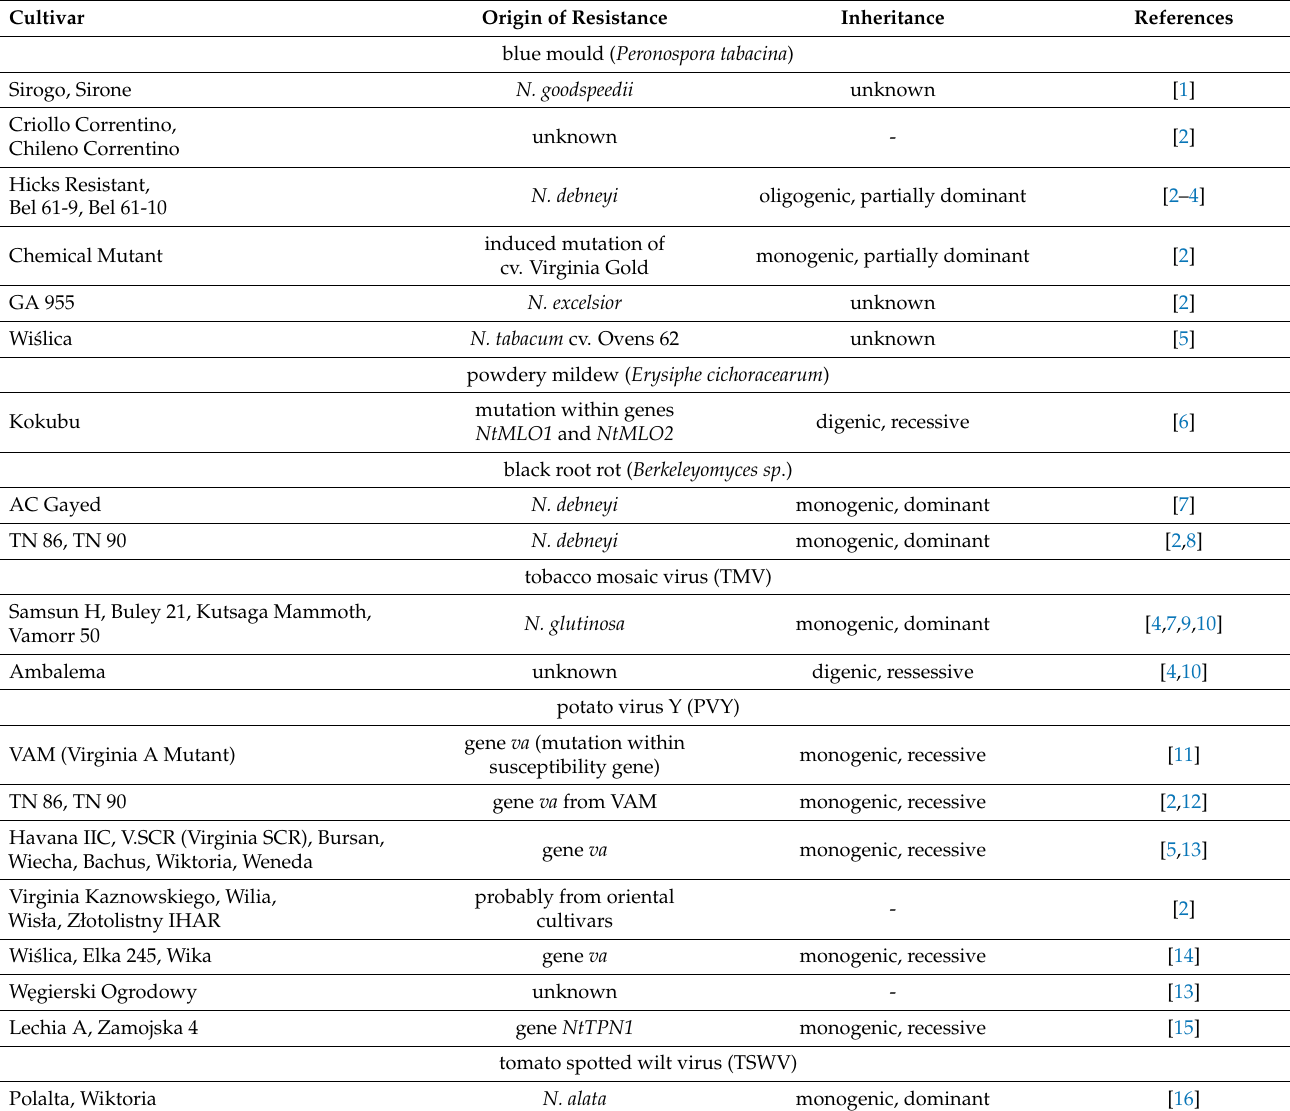
Table 1. Sources of resistance to the most important diseases of tobacco within accessions maintained in the Polish Genebank of N. tabacum